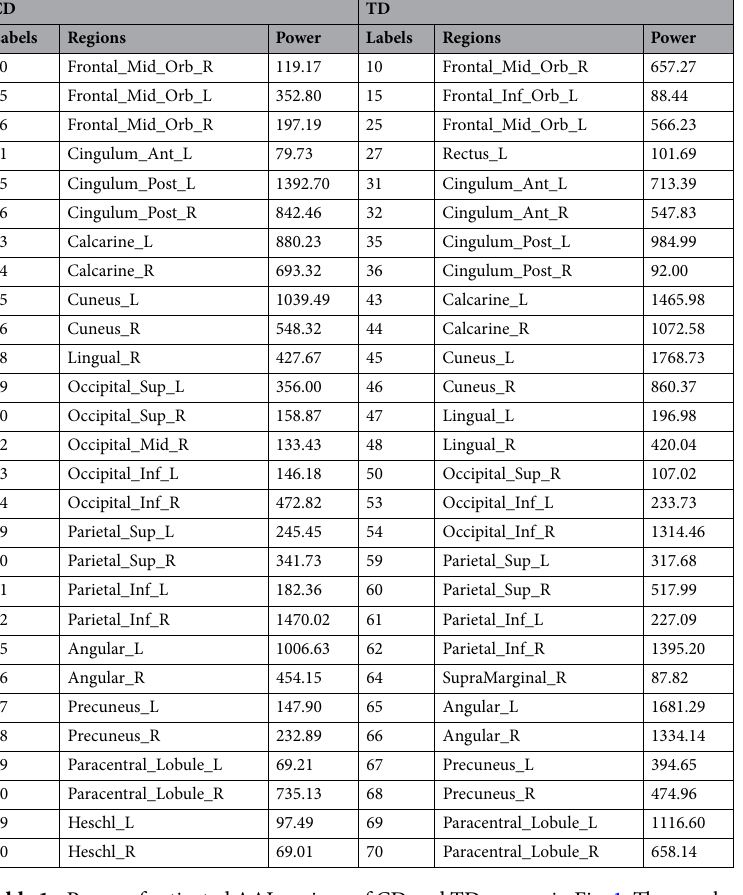
Table 1. Power of activated AAL regions of CD and TD groups in Fig. 1. The numbering sequence of labels is consistent with that of the ninety anatomical regions of interest in the AAL